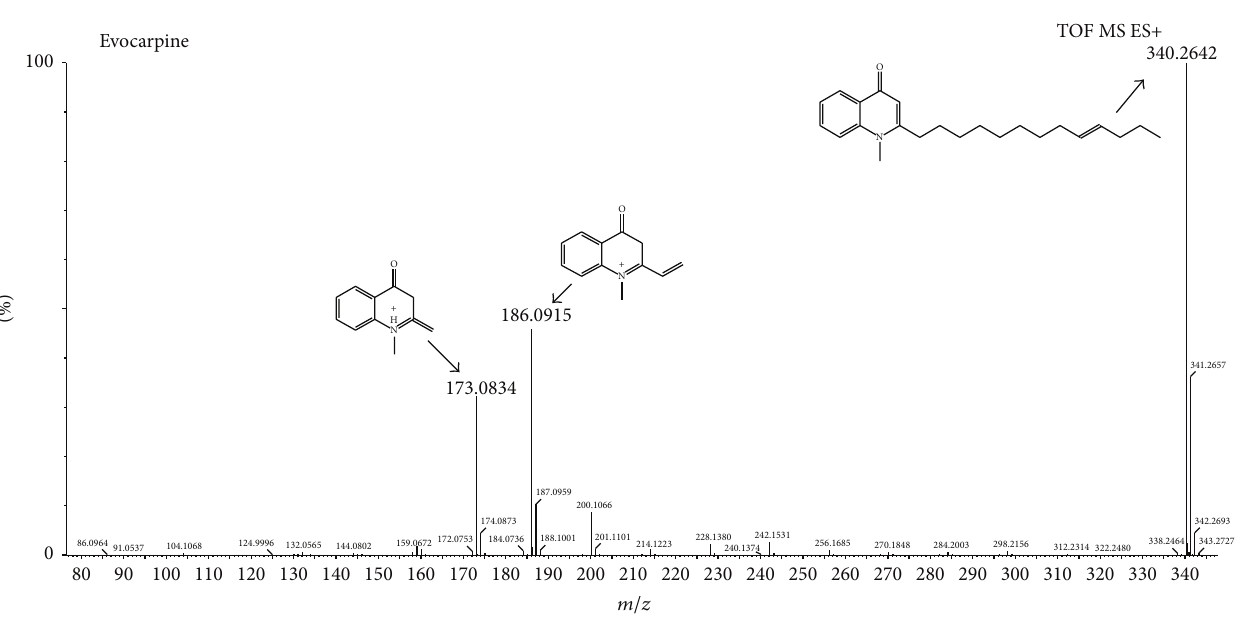
Figure 4: The mass spectrum of evocarpine in quinolone